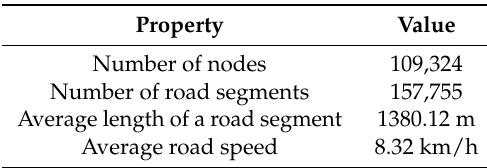
Figure 7. A detailed look at the processed trajectories. ( a ) A subarea of the base map from OSM, and ( b ) a snapshot of the processed trajectory. As shown in ( b ), there are many messy lines around road intersections, which require further processing to extract the real roads.